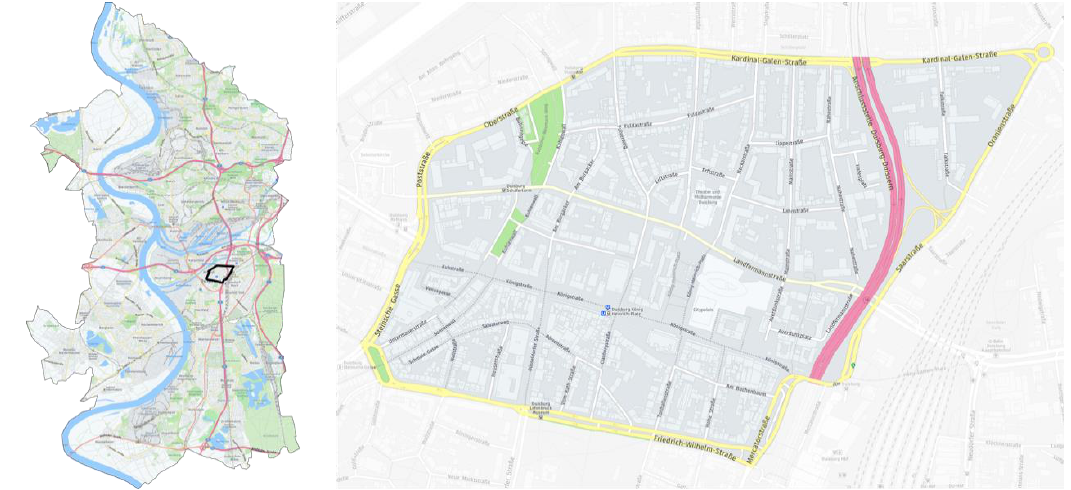
Figure 1. The location of Duisburg inner ring (Source: Here map).